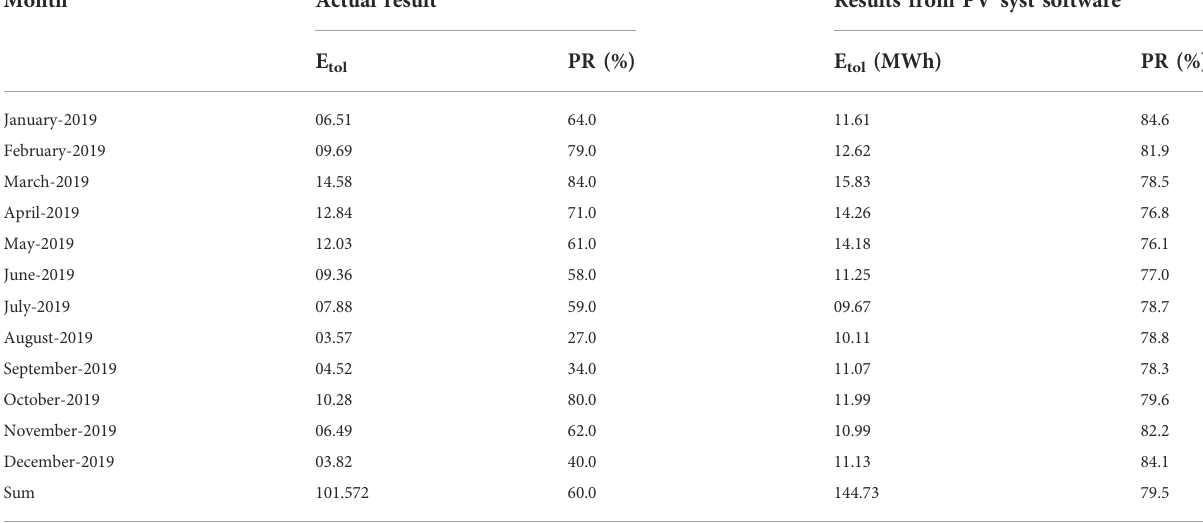
Month Actual result Results from PV*syst